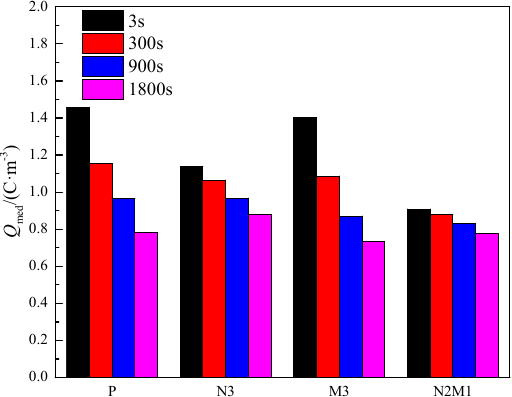
Figure 7. Average charge densities of neat LDPE and ZnO / LDPE composites after an electrode short connection.